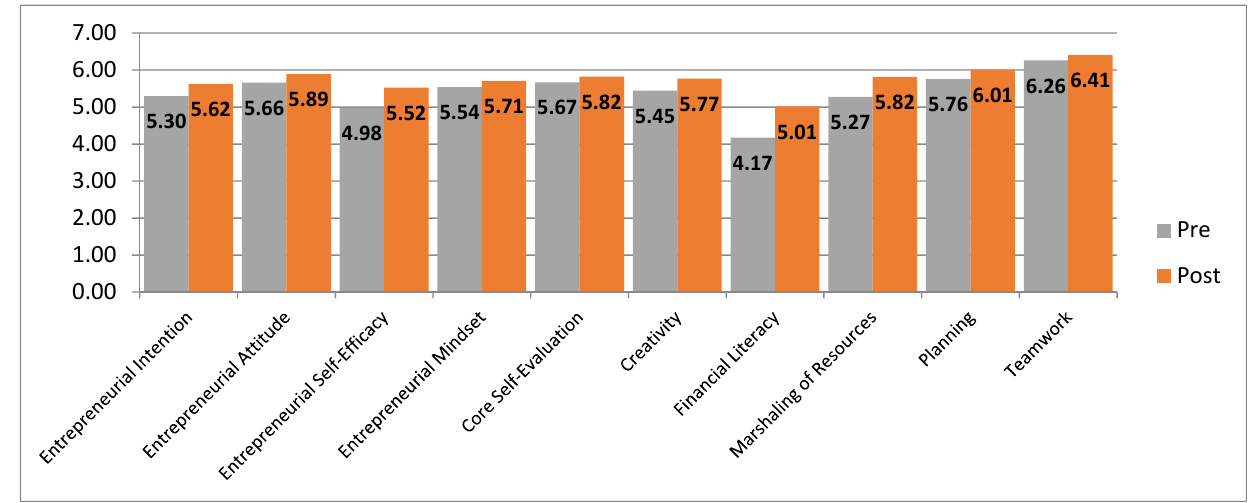
Figure 4. The average values of the entrepreneurial characteristics, pre- and post-course, of the MSc students.